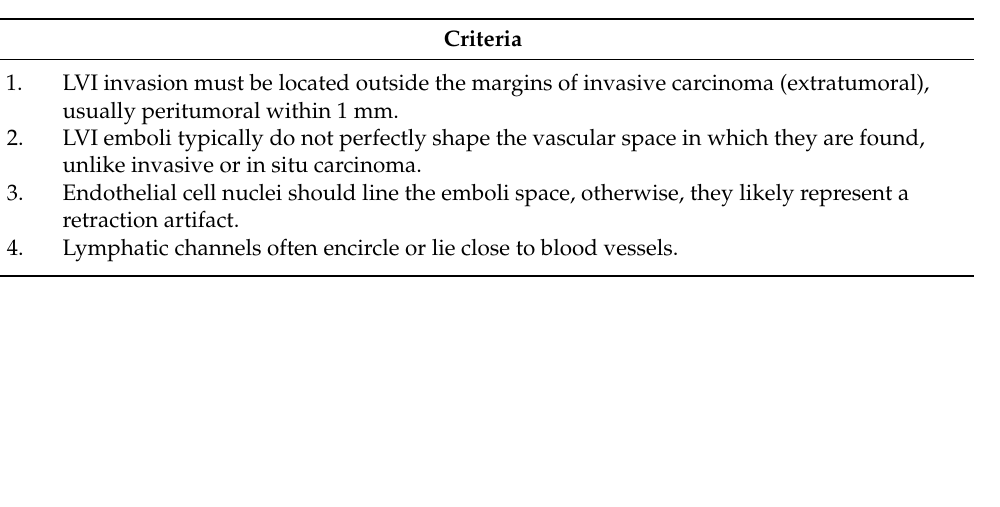
Table 1. Criteria for the histologic diagnosis of lymphovascular invasion by Rosen et al.